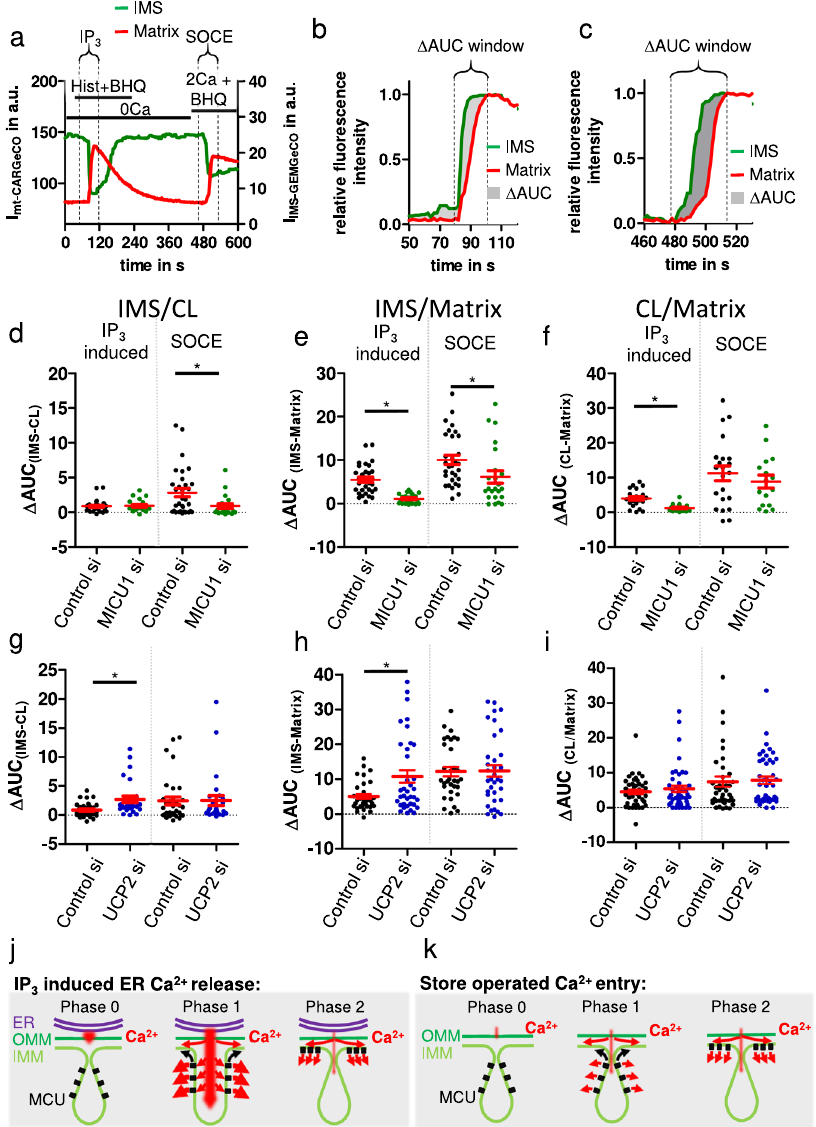
Fig. 5 MICU1 and UCP2 modulate sub-mitochondrial Ca 2 + transition velocity. a Single fl uorescence intensities over time of IMS-GEMGeCO1 (green) and mt- CARGeCO1(red)inHeLacellsuponstimulationwith100 µ Mhistamineand15 µ MBHQinanominalCa 2 + -freebufferandsubsequentreadditionof2mMextracellular Ca 2 + . b Normalized IMS-GEMGeCO1 (green) and mt-CARGeCO1 (red) IP 3 induced Ca 2 + signals with indicated Δ AUC area (gray) with upper and lower time limiting the AUC interval. c Normalized IMS-GEMGeCO1 (green) and mt-CARGeCO1 (red) SOCE induced Ca 2 + signals with indicated Δ AUC area (gray) with AUC interval. Δ AUC was measured in HeLa cells treated with control or MICU1 siRNA between d IMS-GEMGeCO1 and CL-CARGeCO1 ( n = 32; n = 21; n IP3, Control si IP3, MICU1 si SOCE, = 32; n = 21), e IMS-GEMGeCO1 and mt-CARGeCO1 ( n = 31; n = 23; n = 31; n = 23), and f CL- SOCE, MICU1 si IP3, Control si IP3, MICU1 si SOCE, Control si SOCE, MICU1 si Control si GEMGeCO1 and mt-CARGeCO1 ( n IP3, Control si = 22; n IP3, MICU1 si = 17; n SOCE, Control si = 22; n SOCE, MICU1 si = 16) for IP3 and SOCE induced mitochondrial Ca 2 + uptake. Δ AUC was measured in HeLa cells treated with control or UCP2 siRNA between IMS-GEMGeCO1 and CL-CARGeCO1 g ( n = 34; n = 28; n IP3, Control si IP3,UCP2si SOCE, = 34; n = 28), IMS-GEMGeCO1 and mt-CARGeCO1 h ( n = 33; n = 36; n = 33; n = 36), and CL- Control si SOCE, UCP2si IP3, Control si IP3, UCP2si SOCE, Control si SOCE, UCP2si GEMGeCO1andmt-CARGeCO1 i ( n IP3,Controlsi = 43; n IP3,UCP2si = 44n SOCE,Controlsi = 43; n SOCE,UCP2si = 44)forIP 3 andSOCEinducedmitochondrialCa 2 + uptake. j IP 3 induced ER-Ca 2 + release leads to a biphasic Ca 2 + uptake. (1) Ca 2 + hotspot open the CJ and facilitate Ca 2 + fl ux into the cristae from where the Ca 2 + is taken up by constantly active MCU. (2) MCU shuttles MICU1 dependent into the IBM and enables Ca 2 + fl ux into the matrix circumventing the CL. k Store operated Ca 2 + entry is not opening the CJ due to the lack of Ca 2 + hotspots in MAMs. Accordingly, the fi rst phase of Ca 2 + uptake is hampered resulting in a delayed Ca 2 + uptake primarily through MCU shuttling into the IBM. Data information: data are shown as scatter plots with each dot representing one cell. The mean + / − SEM are indicated as red line and whiskers. * P <0.05 vs. respective control conditions carried out with unpaired double-sided T test.